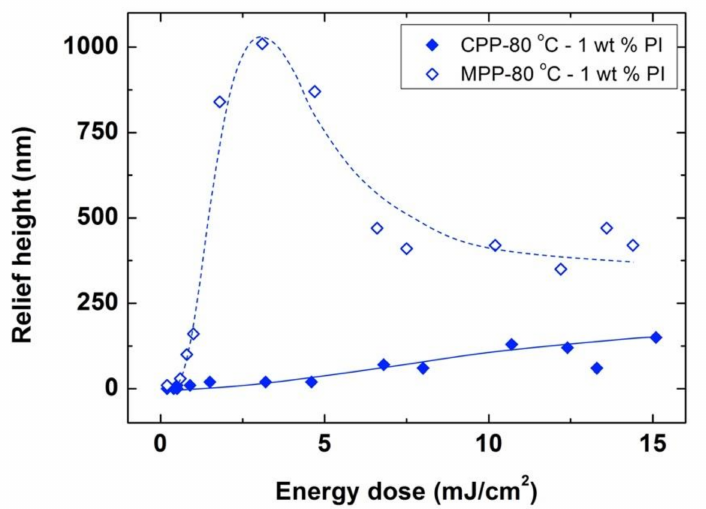
Figure 5. Relief height as a function of energy dose for photoembossed samples bearing 1 wt% photoinitiator. The exposure step using IL (single pulse exposure and 9 µ m period grating) is performed either at RT followed by a development step at 80 °C ( ) or directly at the development temperature ( ). In both cases, the samples were kept at this development temperature for 10 min. Lines are drawn to guide the eye.